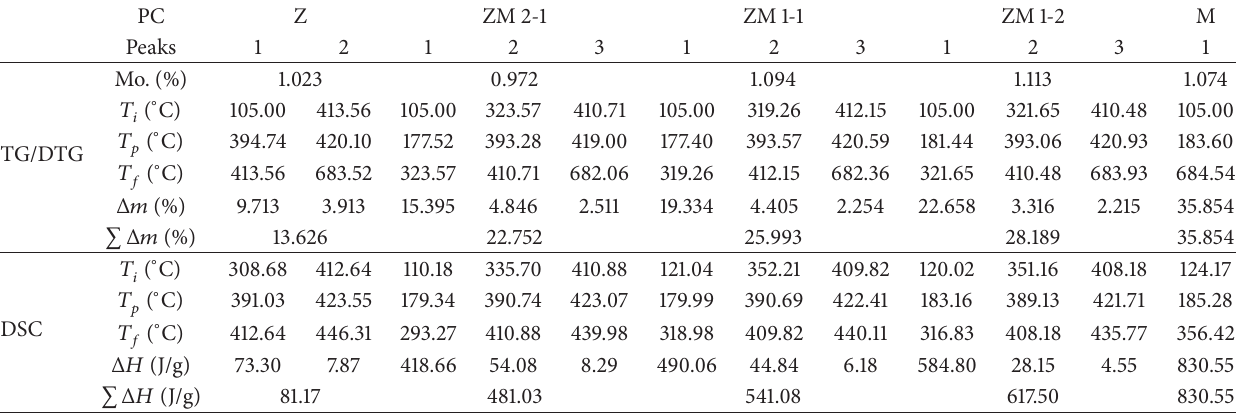
Table 7: TG/DTG and DSC results of the synthesised magnesium borate minerals and zinc borate.